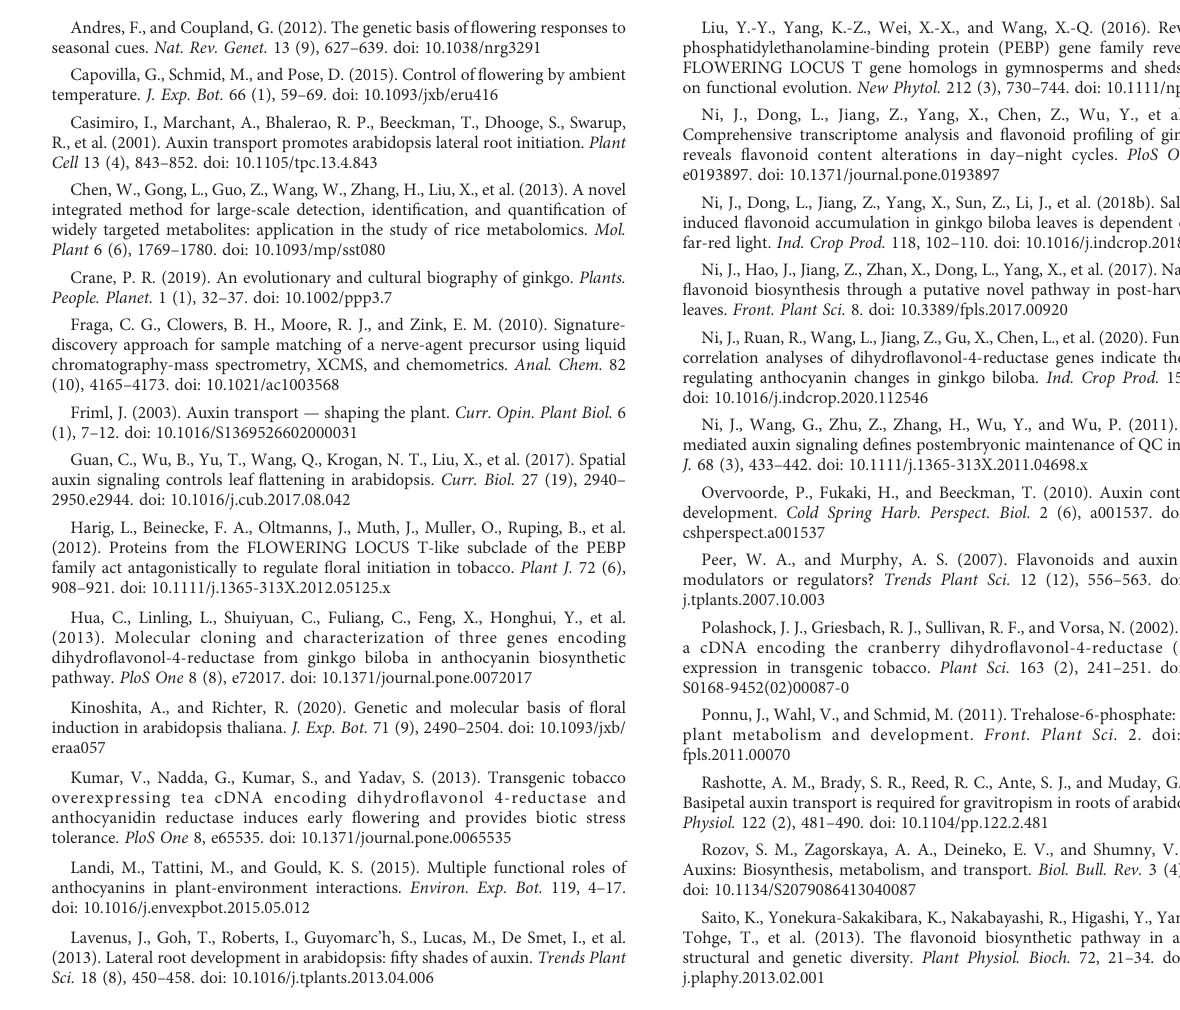
SUPPLEMENTARY TABLE 2 Upregulated and downregulated fl avonoid compounds detected in